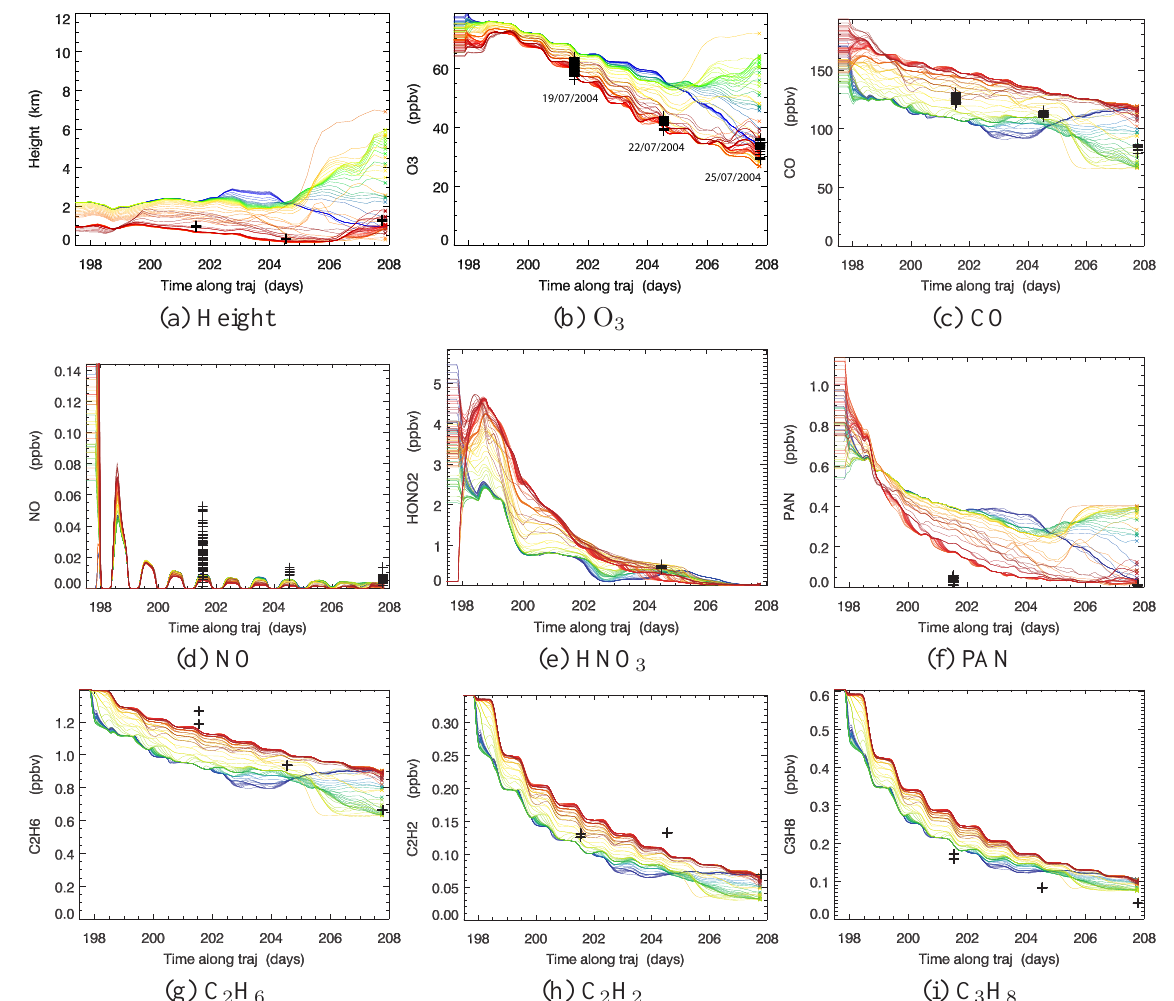
Fig. 1. Case 1 ensemble of trajectories for the control simulation. Trajectories are coloured by their release time from the flight track on Fig. 1. Case1ensembleoftrajectoriesforcontrolsimulation. Trajectoriesarecolouredbytheirrelease 15 July 2004 so that individual trajectories can be distinguished. The red and orange trajectories pass nearest all downwind flight locations. time from the flight track on 15 July 2004 so that individual trajectories can be distinguished. The Crosses show observations from Lagrangian aircraft intercepts defined by Methven et al. (2006). The time axis is days from 00:00UT redandorangetrajectoriespassnearestalldownwindflightlocations. Crossesshowobservationsfrom 1 January 2004. NO y observations from the DLR Falcon are shown at day 204 on the HNO 3 LagrangianaircraftinterceptsdefinedbyMethvenetal.(2006)(crosses). Timeaxisisdaysfrom00UT observationsfromtheDLRFalconareshownatday204ontheHNO 3 plot. 1/1/2004.NO y